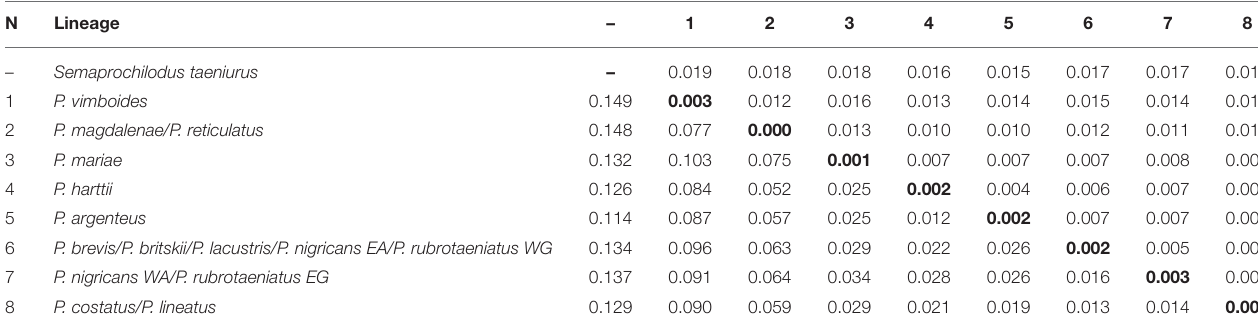
TABLE 1 | Pairwise K2P genetic distance among distinct lineages of Prochilodus (below diagonal) and standard error (above diagonal). N